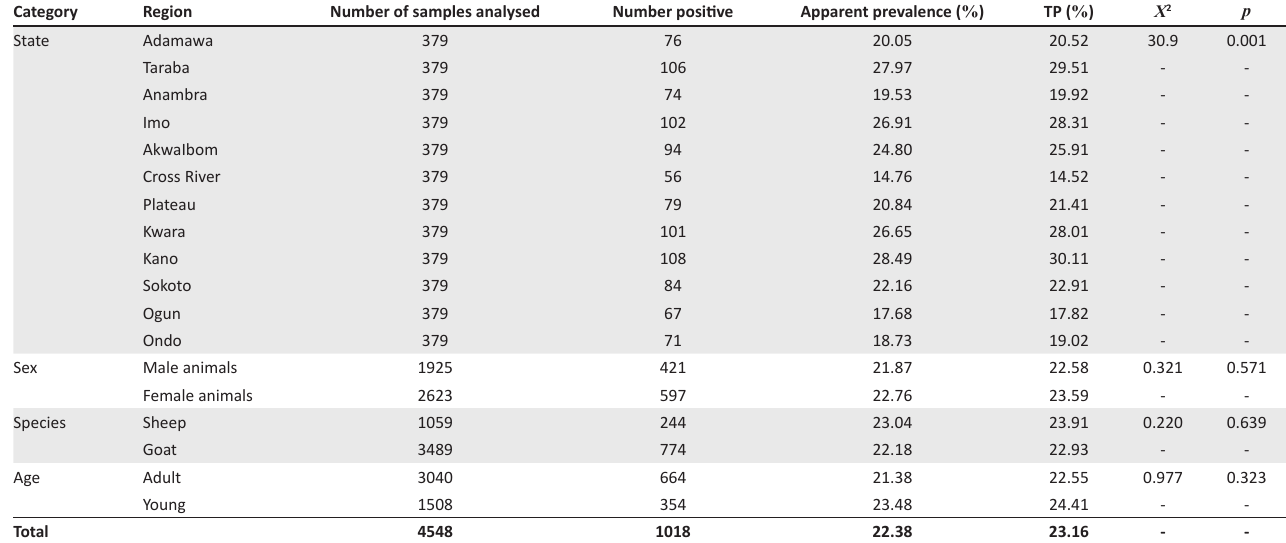
TABLE 1: Apparent and true prevalence of peste des petits ruminants virus antibodies in small ruminants in Nigeria, 2010–2013.